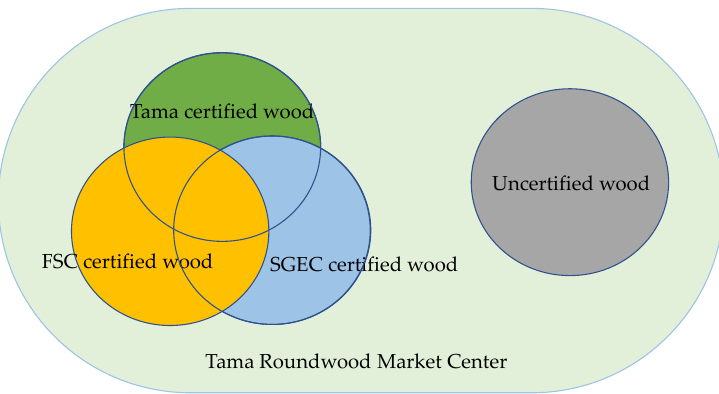
Figure 2. Treatment of double- and triple-certified raw wood